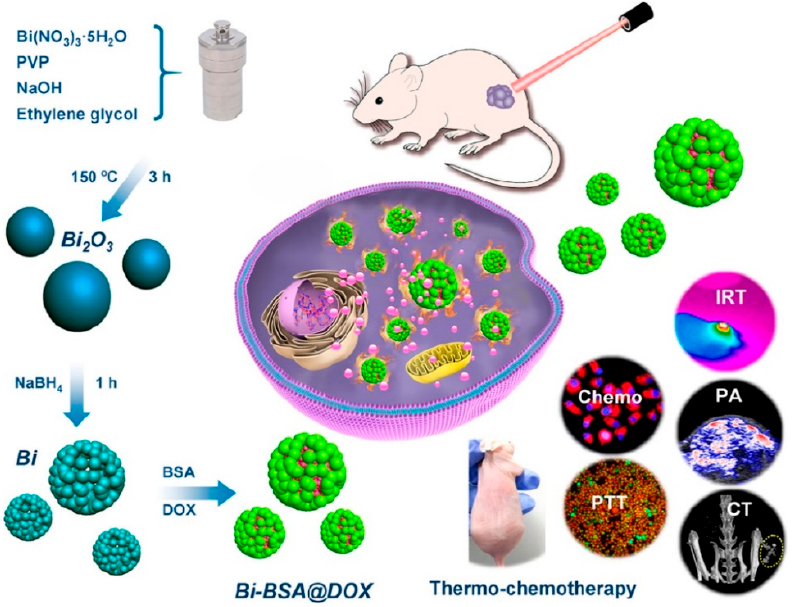
Figure 9. Production and biological action of bismuth oxide nanoraspberries species as reported by Li et al. [106]. Copyright 2018 American Chemical Society. Bismuth oxides and related materials could be also combined with other